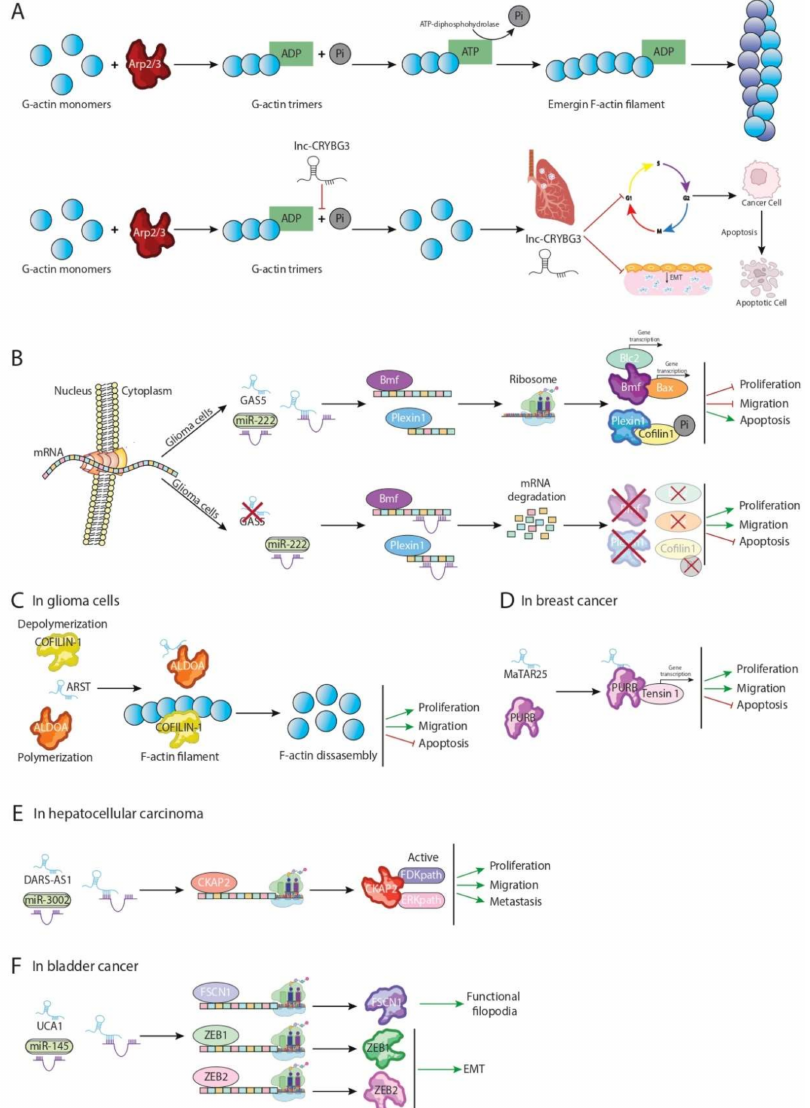
Figure 3. Schematic representation of several mechanisms related to cytoskeletal lncRNAs function: ( A ) blocking phosphorylation of G-actin mediated by Lnc-CRYBG3; ( B ) sponge GAS5-miR 222 enhances Bmf and Plexin1 translation leading to a reduced cellular proliferation and migration ratio; ( C ) ARST binds to ALDOA avoiding its interaction with F-actin, and in turn, Cofilin-1 binds to F-actin filament increasing the disassembly ratio; ( D ) MaTaR25-PURB complex is required for correct expression of Tensin1, which in turn increases proliferation and migration of glioma